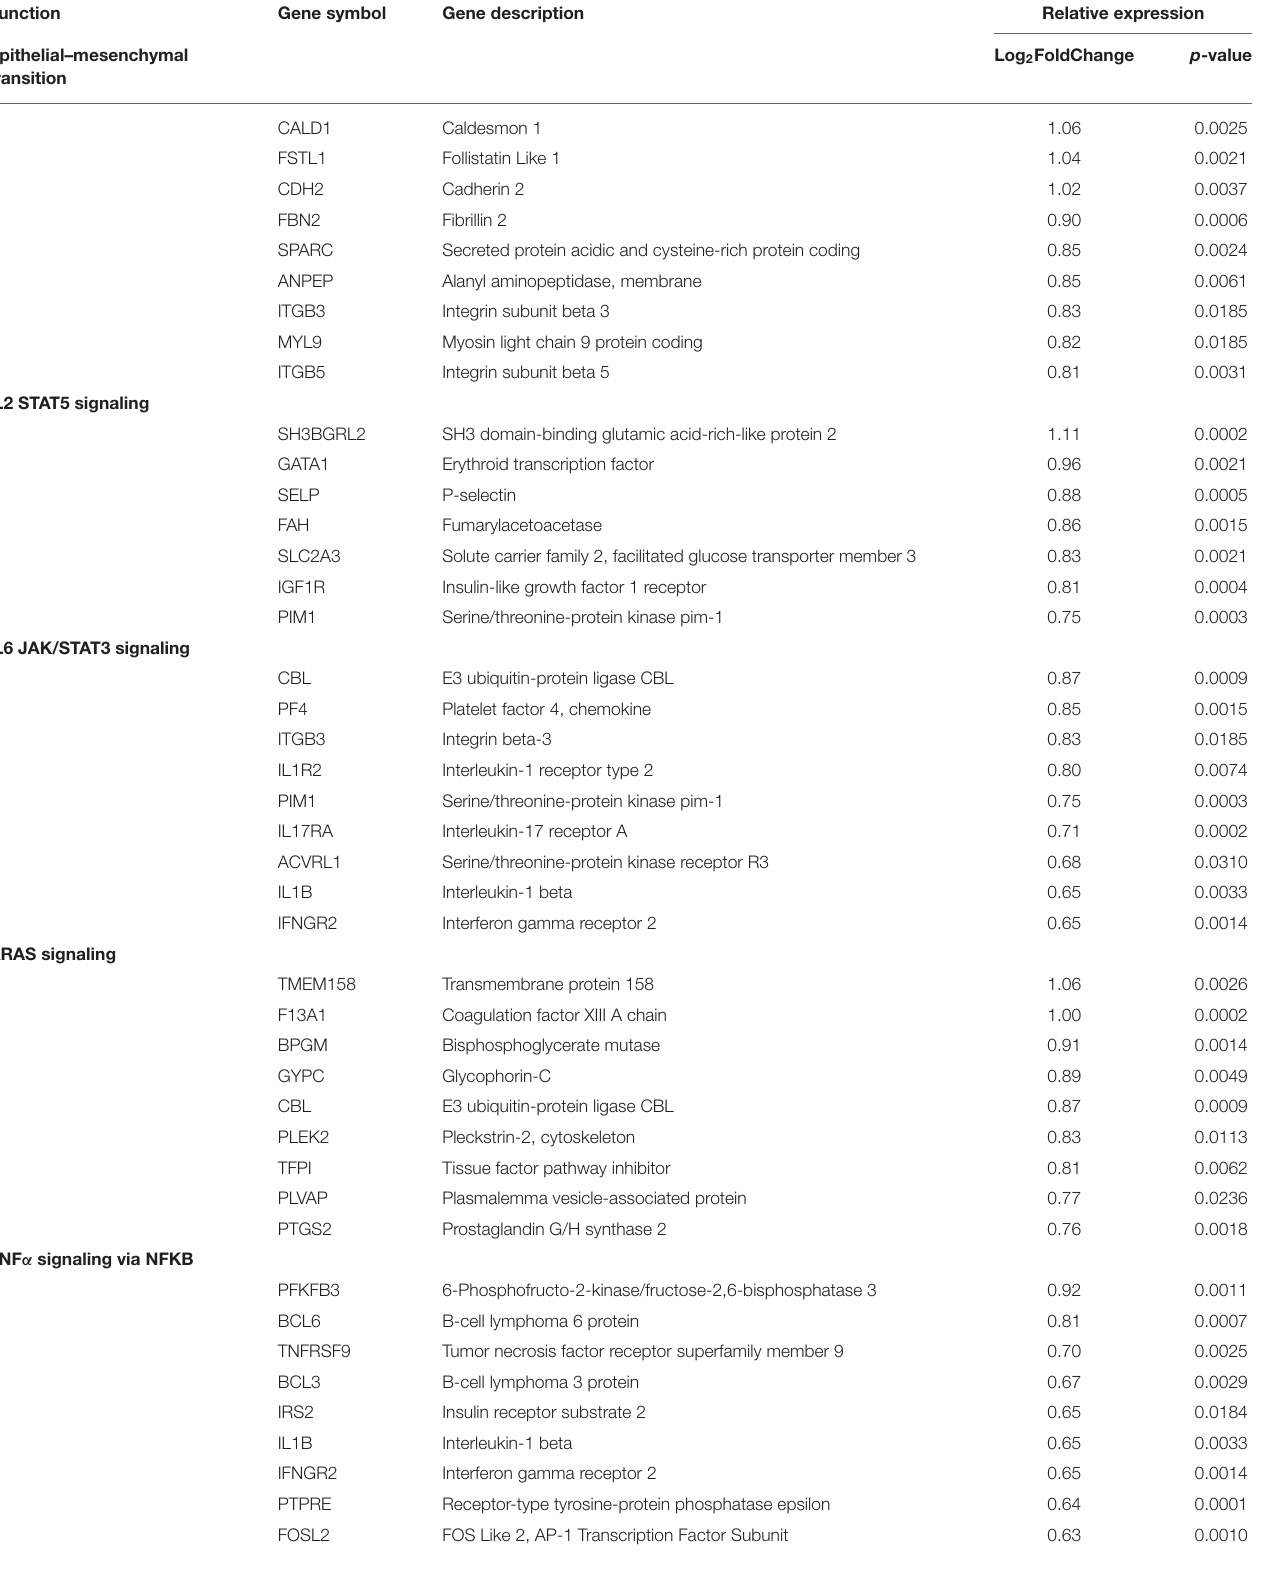
TABLE 8 | Pediatric active vs. inactive localized scleroderma sample comparison identifies gene enrichment groups of interest.